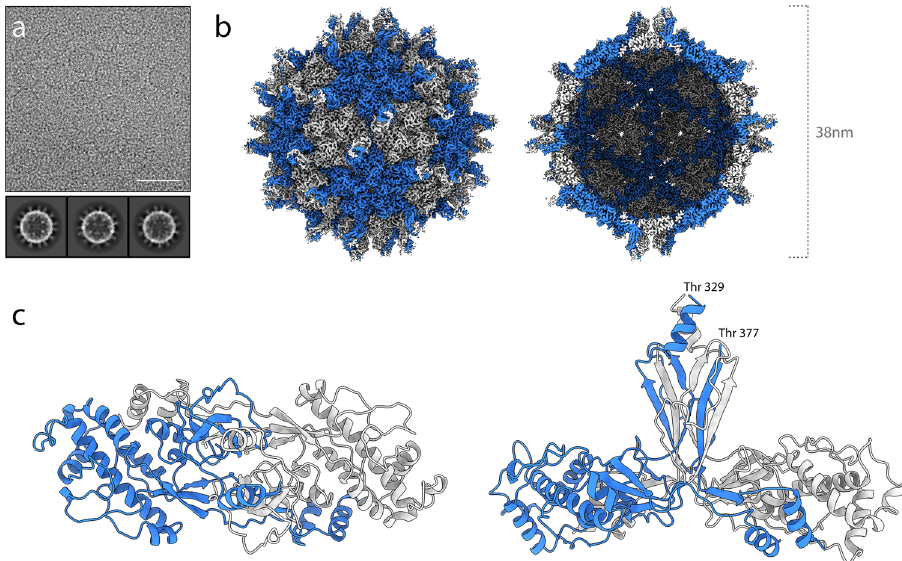
Fig. 1 The cryo-EM structure of PCV-1. a A section of a representative micrograph of PCV-1 and 2d class averages. b The 2.9 Å resolution 3D reconstruction of PCV-1, coloured according to quasi-conformer, with monomer A coloured blue and monomer B coloured grey, (left) capsid surface (right) central slice through capsid. c The atomic model of PCV-1, showing the model for a single asymmetric unit, comprising A/B quasi-conformers coloured blue and grey, respectively.